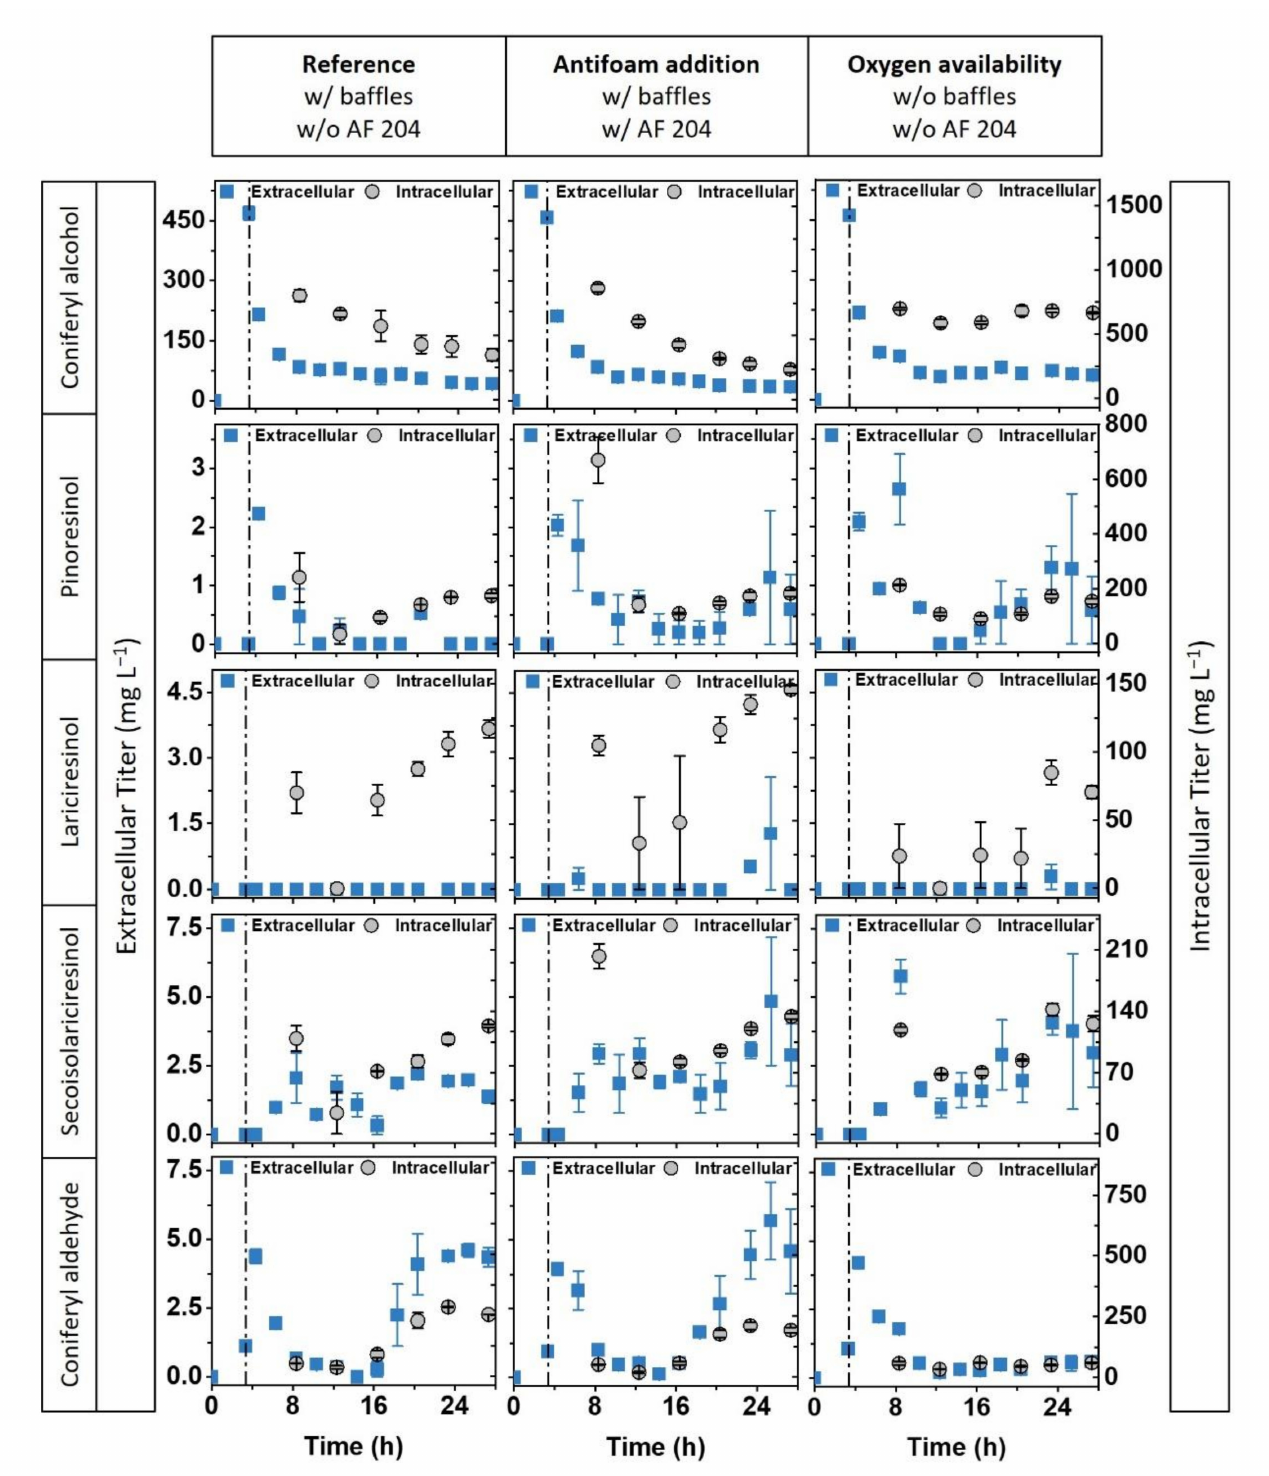
Figure 3. Influence of antifoam addition and oxygen availability on lignan production in shake flasks. E. coli C43(DE3) pCDFDuet_syfiPLR was cultivated in baffled (w/baffles) or unbaffled shake flasks (w/o baffles). For some shake-flask cultivations, 0.01% ( v / v ) AF204 (w/AF204) was added. Cells were grown at 37 ◦ C, 180 rpm, in modified Riesenberg medium. At OD 600 0.6, 0.75 mM IPTG was added for induction. Amounts of 50 µ M CuSO 4 and 0.5 g L − 1 coniferyl alcohol were added at the same time (indicated by pointed-dashed line). After induction, the cultivation temperature was reduced to 30 ◦ C. Cultivations were ended 24 h after